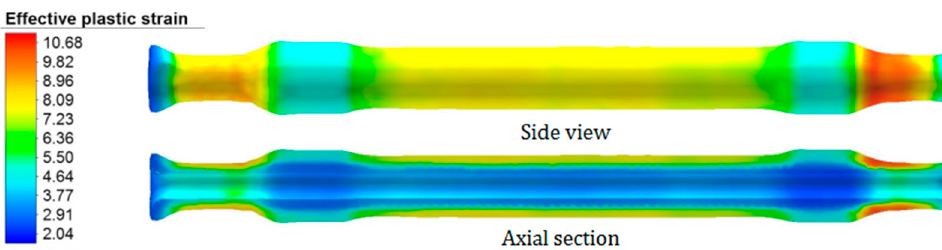
Figure 29. Change of force parameters of each part during forming [37] (Reprinted from ref. [37]).